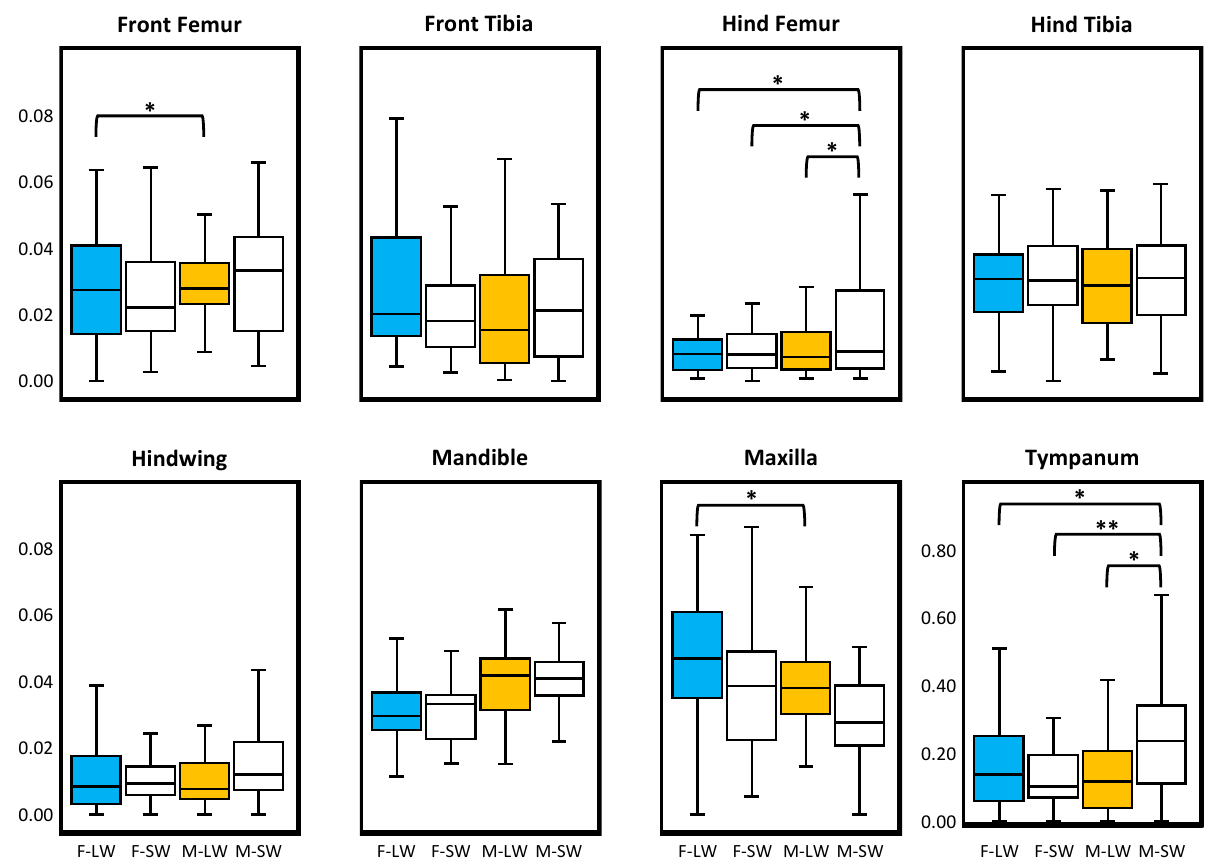
Figure 4. Boxplots comparing size-corrected fluctuating asymmetry values across the eight univariate traits. Females and males are represented by blue and orange, respectively, whereas longwing and shortwing morphs are distinguished by dark and light shading. Plots of linear measurements have a standardized range of 0.00–0.10 mm; tympanum has a scale of 0.0–1.0 mm 2 . Boxes enclose the median (centerline) and the 25th and 75th percentiles. Whiskers indicate the 10th and 90th percentiles. Significance levels of Tukey tests are indicated in plots: * p < 0.05, ** p < 0.01. Only significant pairwise comparisons are noted; all Tukey tests results are provided in Table S3.